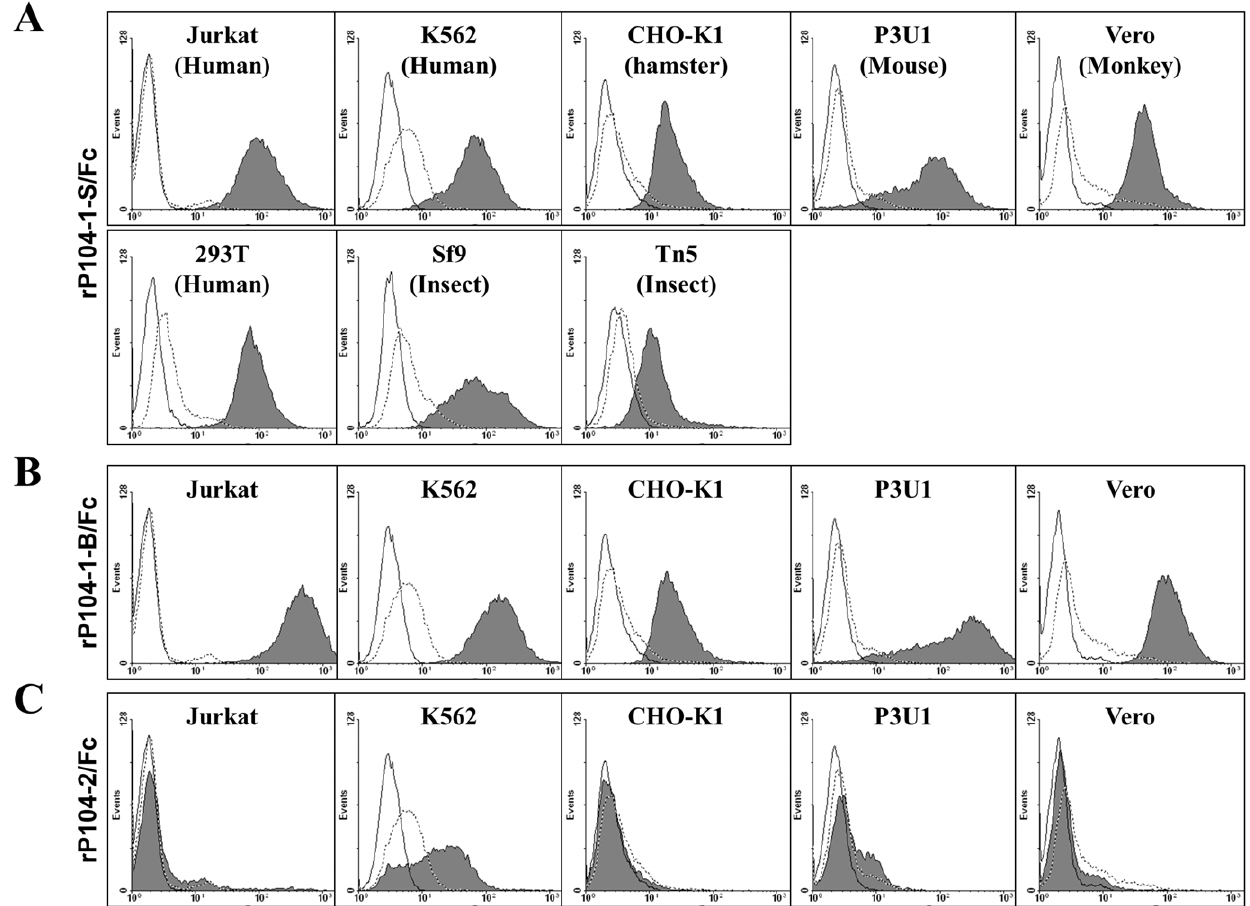
Figure 4. FACS analysis of the cellular binding activity of rP104-1-S/Fc and rP104-1-B/Fc. A. Different types of cells were incubated with rP104-1-S/Fc before being stained with anti-Fc-FITC antibodies and subjected to FACS analysis with Cell Quest software. B. FACS analysis of cells incubated with rP104-1-B/Fc. C. FACS analysis of cells incubated with rP104-2/Fc. In all panels, cells (solid line) and cells incubated with Fc (dotted line) were employed as negative controls. Gray-filled histograms indicate the cells incubated with recombinant